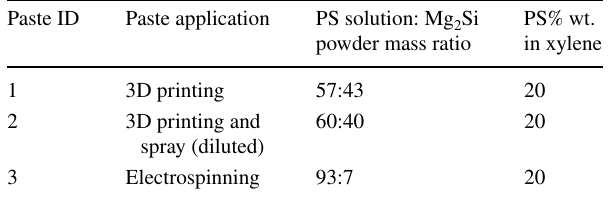
shown in b and c . The average grain size taken from each micrograph is indicated together with the standard deviation Table 2 Mg 2 Si paste formulations prepared with polystyrene (PS) solution for 3D printing and fiber production by spray and electro- spinning Paste